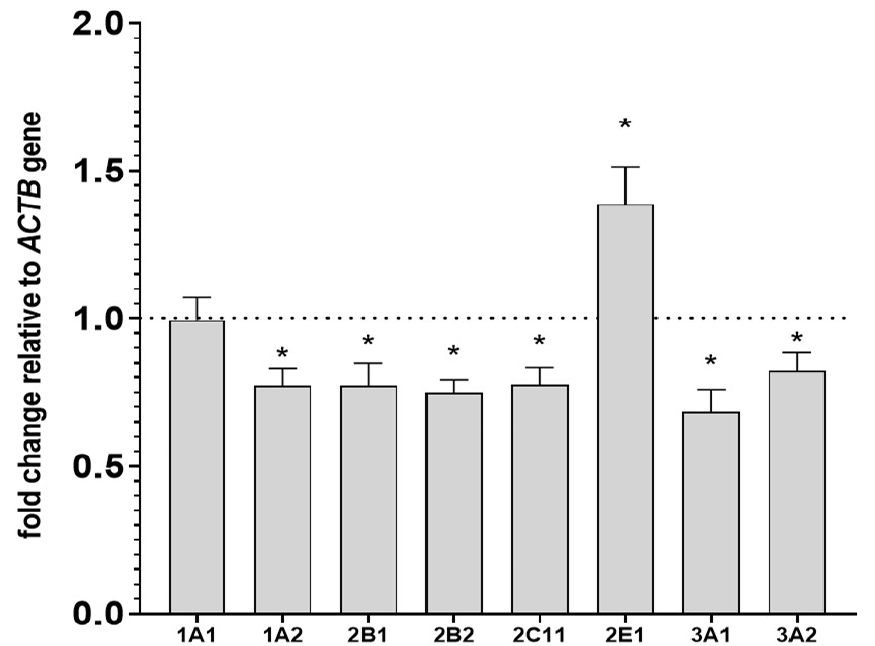
Figure 3. The effect of two-week treatment with iloperidone on the mRNA levels of CYP1A , CYP2B , CYP2C11 , CYP3A , and CYP2E1 genes in the liver. The results are expressed as the fold-change in relation to the ACTB housekeeping gene. All the values are the mean fold-change calculated by the comparative delta-delta Ct method for the control and iloperidone-treated rats. All values are the means ± S.E.M. ( n = 10). The significance of differences between the results was calculated using Student’s t -test. Statistical significance is shown as * p < 0.05 vs. control group.